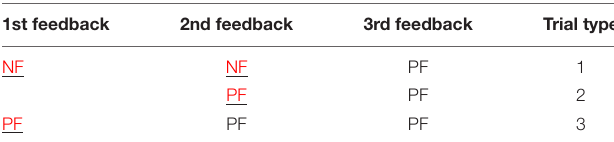
TABLE 1 | Three types of trials in which participants acquired the rule